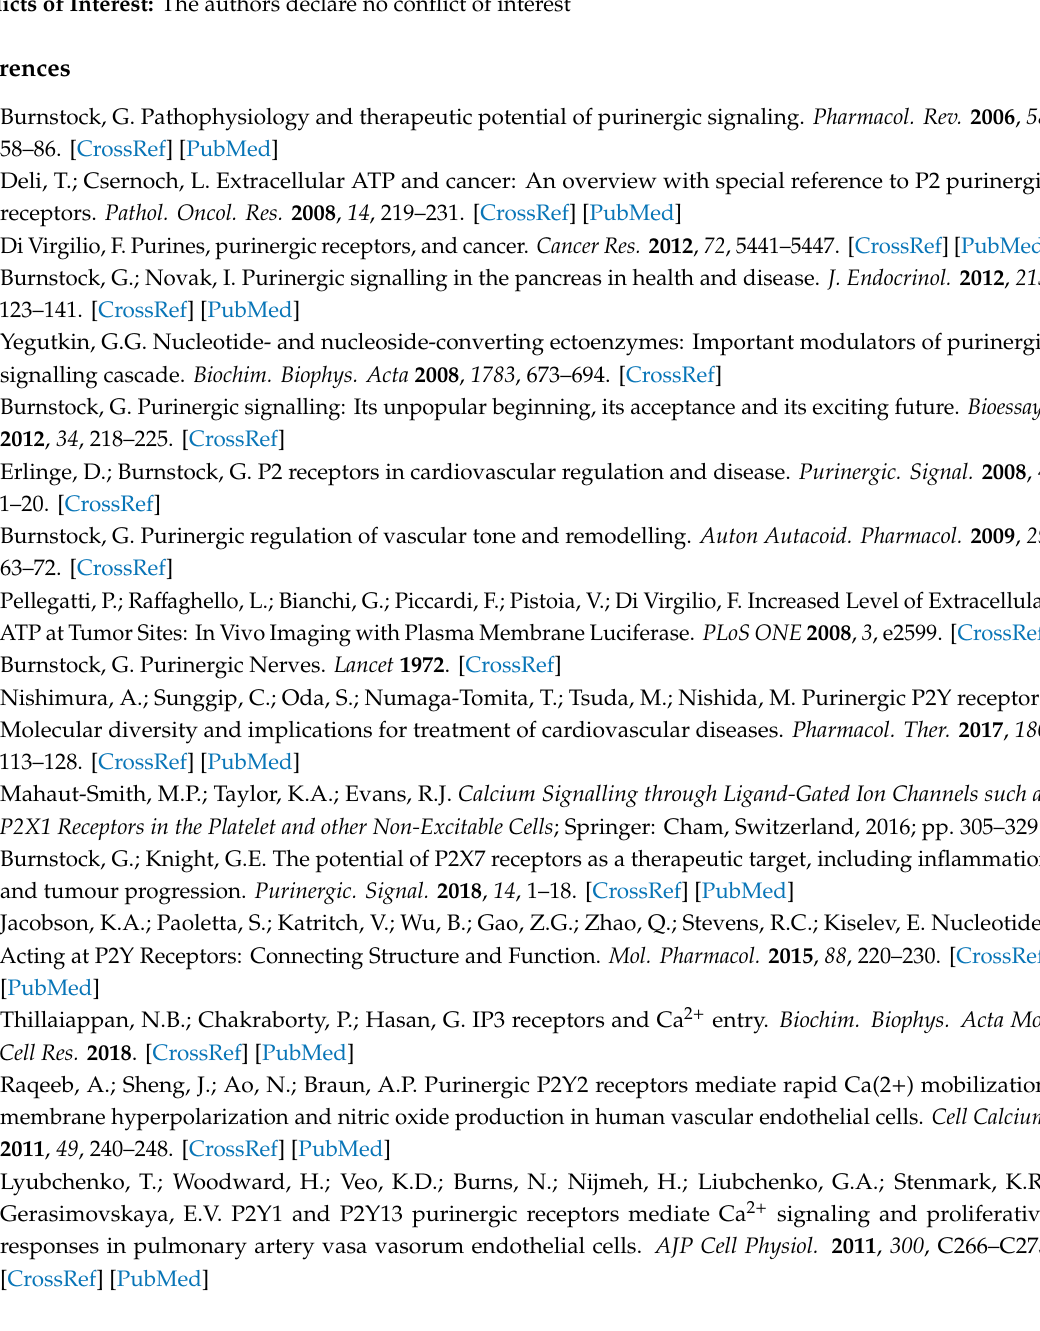
Figure S1: Characterization of high ATP stimulation in RTEC. Figure S2: P1 receptors are expressed and functional in